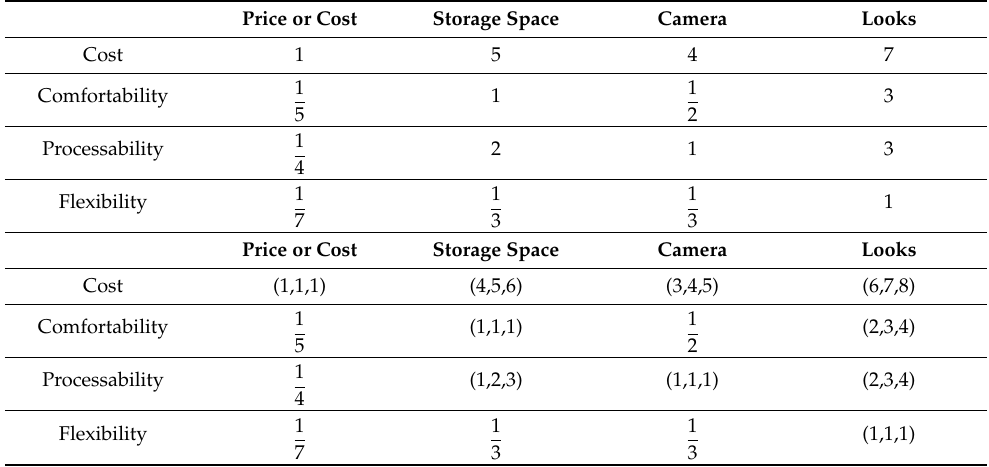
Table 6. Pairwise comparison